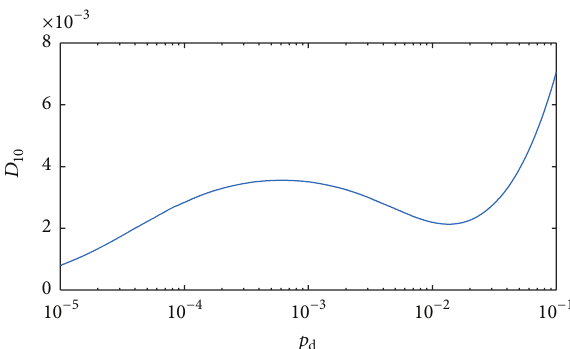
Figure 7: Probability of early tumor death event for different plasticity event probability and for parameters considered in the main